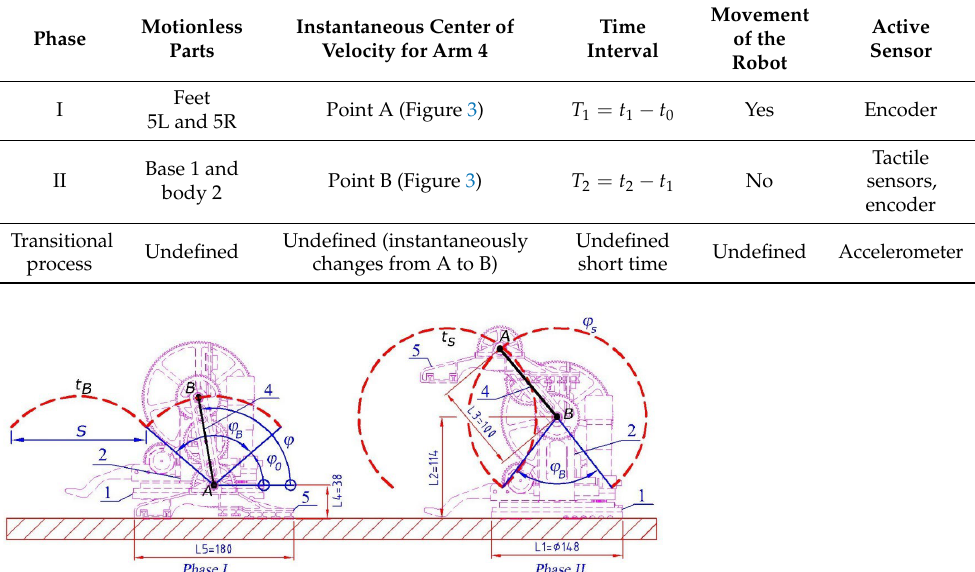
Table 1. Processes during the different phases of motion. Motionless Instantaneous Center of Phase Parts Velocity for Arm 4